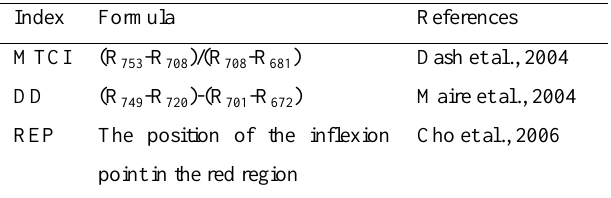
Table 2. Summary of vegetation indices